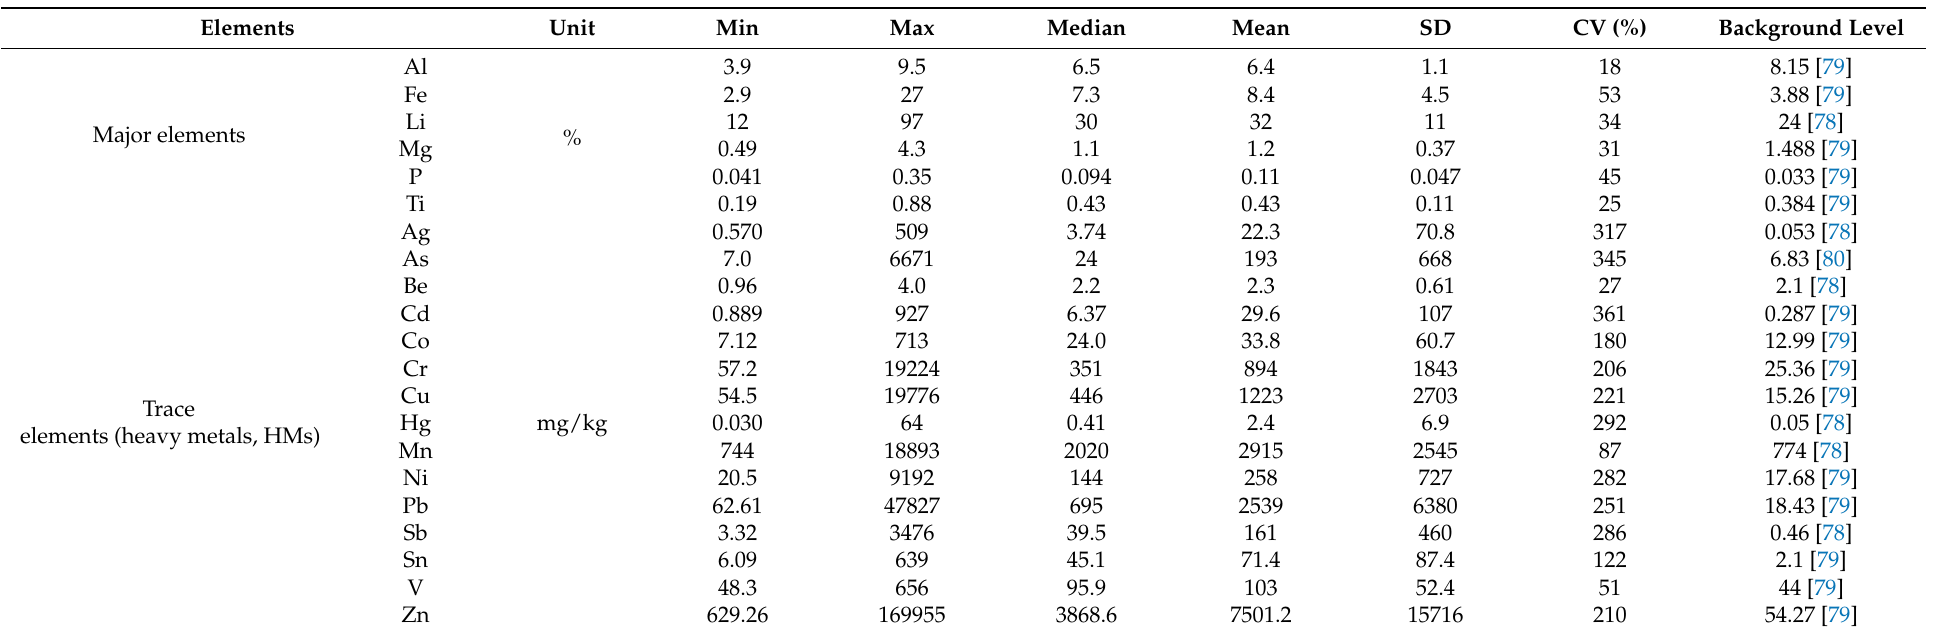
Table 3. Statistical characteristics of major and potentially toxic elements in PM10 of RDS from nine national industrial complexes in South Korea.